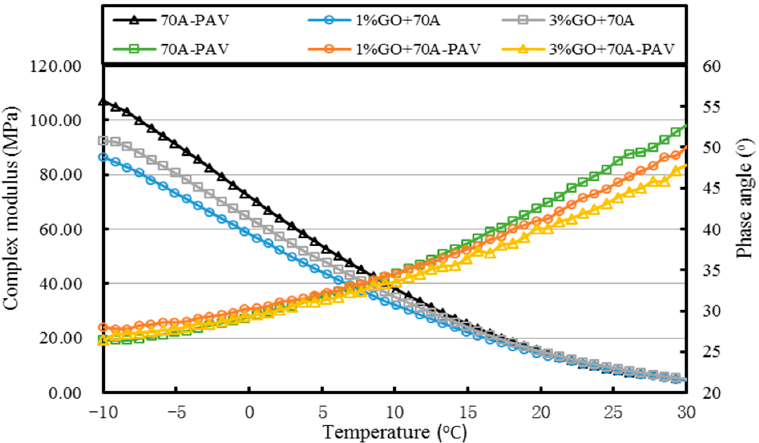
Figure 17. Complex modulus and phase angle of GO-modified 70A and its matrix at low temperature after PAV aging.